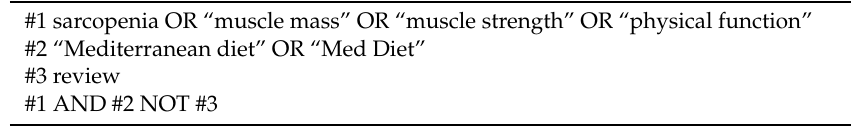
Table 1. Search strategy on Pubmed.